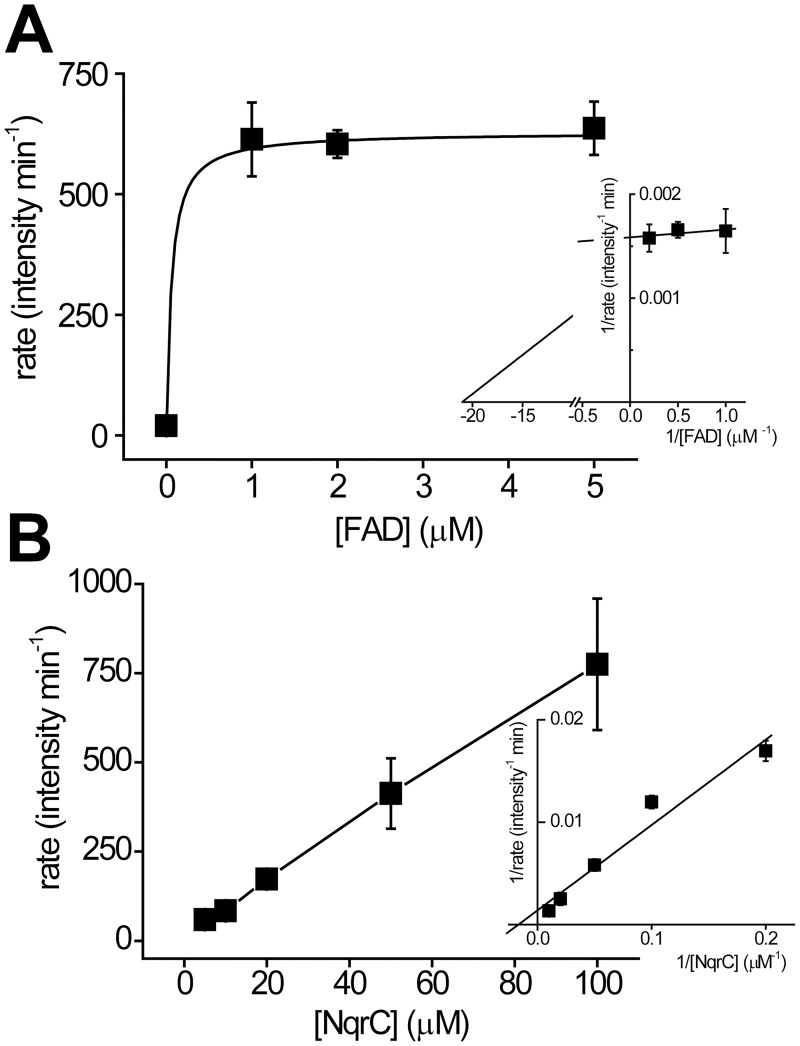
Substrate titration of ApbE.A and B) FAD and NqrC titrations on the steady state activity of ApbE, respectively. The titrations were performed by varying the concentration of one substrate at a fixed concentration of the other (FAD 1 mM, NqrC 100 μM). Inset shows the double reciprocal plots. The kinetic parameters were obtained by fitting the data to the Michaelis-Menten equation.